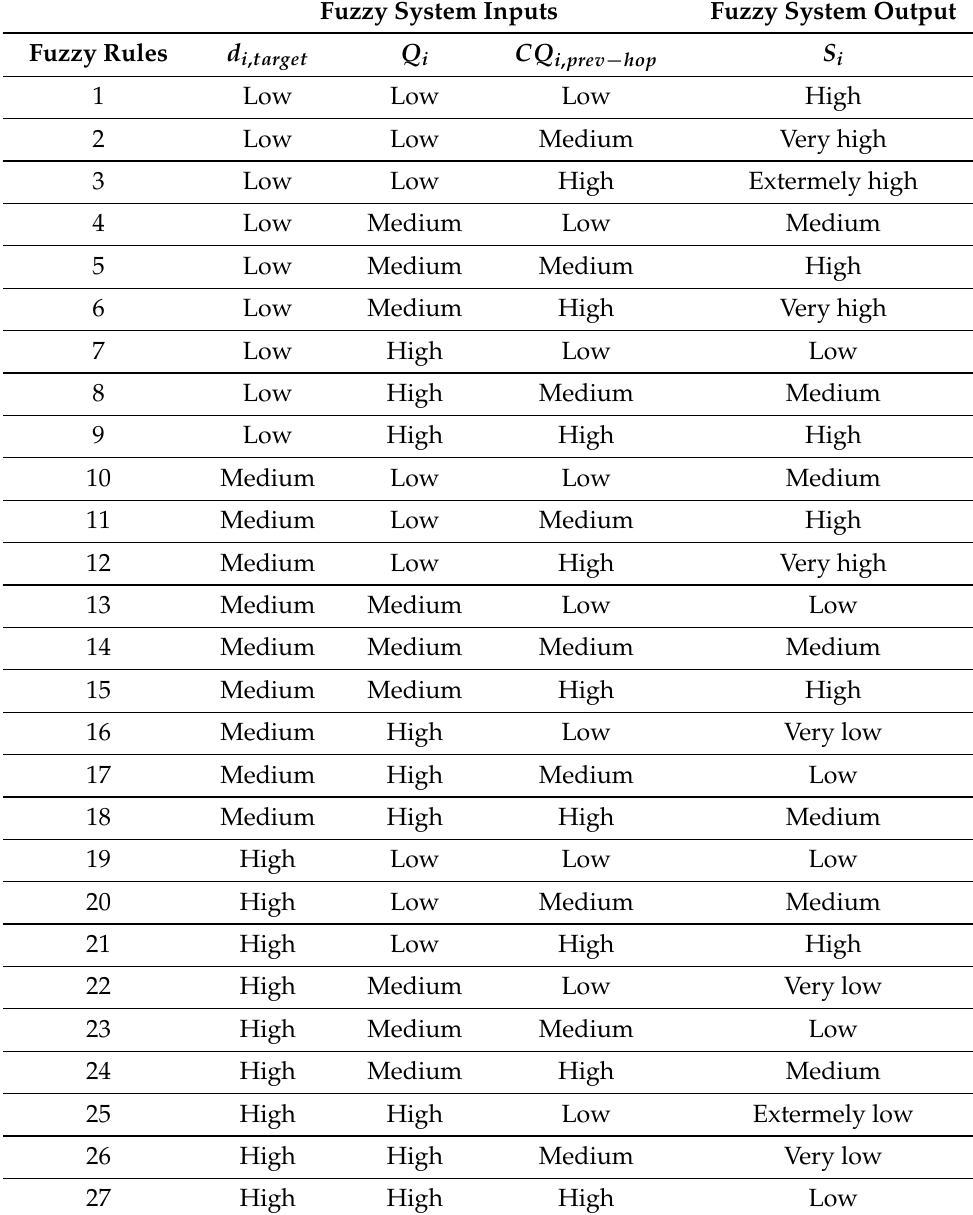
Table 4. Fuzzy rule base in proposed fuzzy